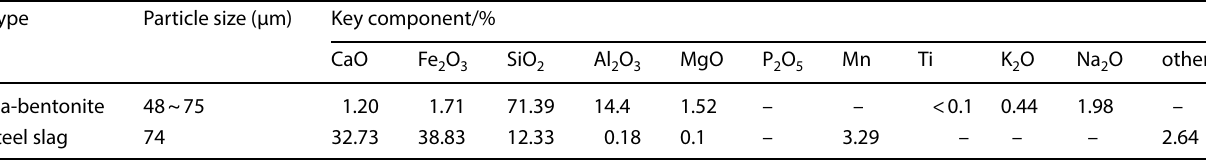
Table 5 The data of bentonite and steel slag Type Particle size (μm) Key